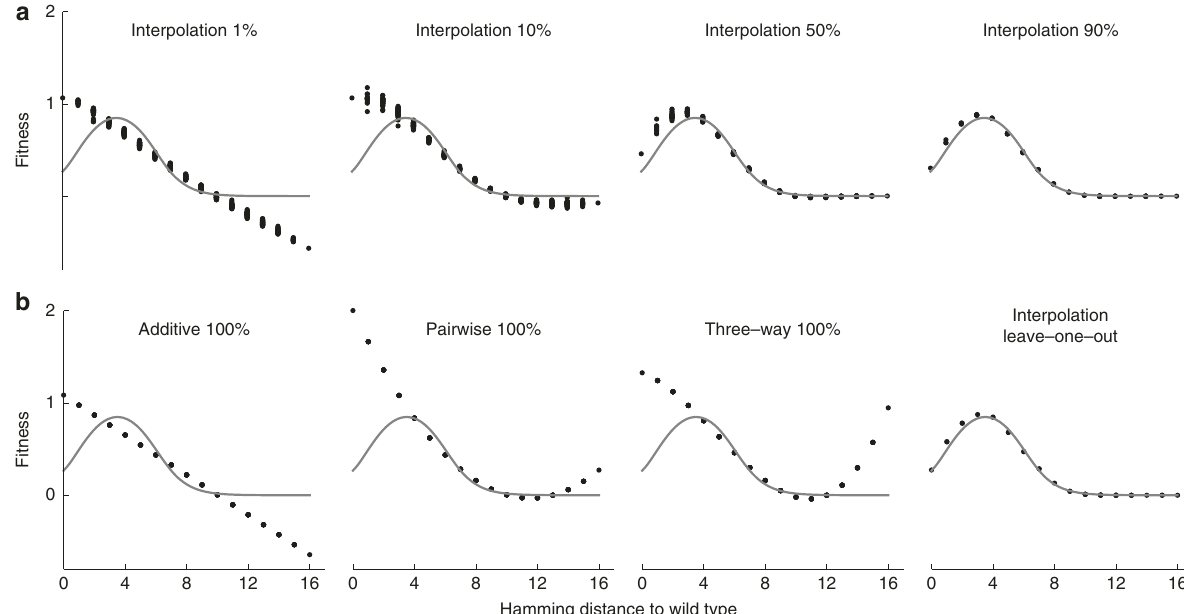
Fig. 2 Minimum epistasis interpolation but not low-order regression models can learn the crater model for transcriptional regulation. The crater model produces a fi tness landscape where fi tness depends only on the Hamming distance to the wild-type sequence, with an optimum at an intermediate Hamming distance ( l = 16 and α = 2; see “ Methods ” for other parameters). Gray curve shows the true fi tness landscape. a Out-of-sample predictions of minimum epistasis interpolation with random subsets of 1%, 10%, 50%, and 90% of genotypes used for training. The predictions adapt to the shape of the crater landscape with increasing data density. For each distance class, at least one genotype was assigned to the test set to ensure an informative visualization of model fi ts. b Reconstruction of the crater landscape by the additive, pairwise, and three-way regression models fi tted using ordinary least squares with 100% of the data. The interpolation panel shows leave-one-out results (equivalent to applying the smoother M to the full